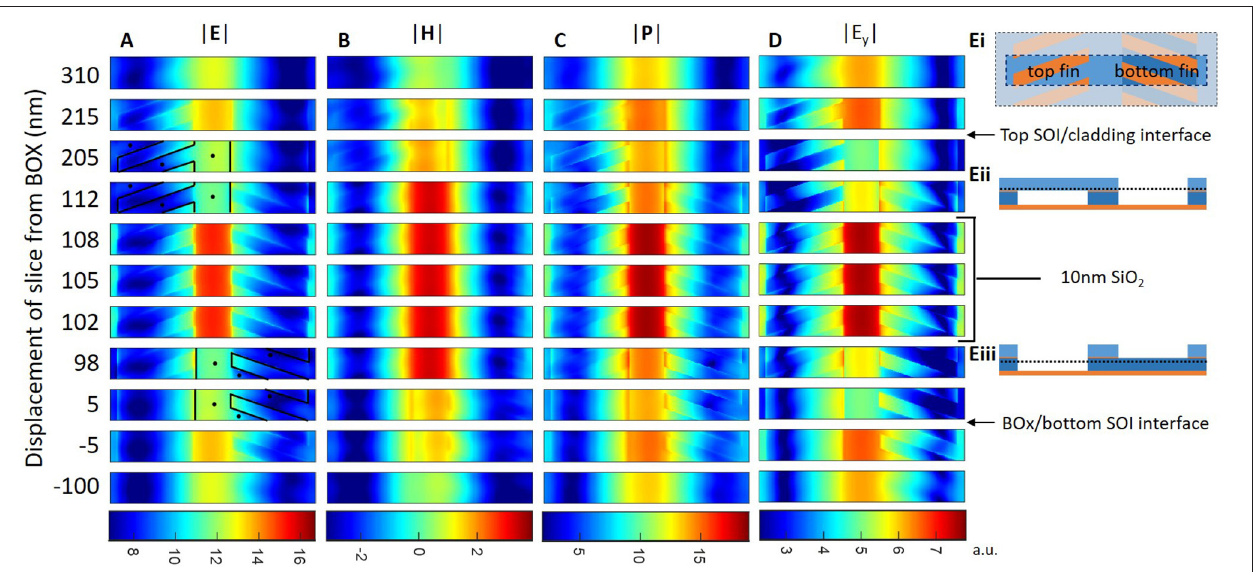
FIGURE 5 | (A–D) | E | , | H | , | P | , | E y | profiles (log-scale) of guided quasi-TM slot mode from 3D FDTD simulation performed for m = 0.5, k z = 0.43 × 2 π/3 , 3 = 400 nm, fin-width = 200 nm, normalized frequency ( f ) = 0.264 ( λ = 1517 nm). (Ei) Shows the Bloch repeating simulation region (highlighted). (Eii,Eiii) Show the top-fin/bottom-fin waveguide section profile above/below the 10 nm SiO 2 layer. The waveguide and fin sidewalls have been overlaid by a black line for the 3rd-4th profile (upper-fin) and 8th-9th profile (lower-fin) of (A)